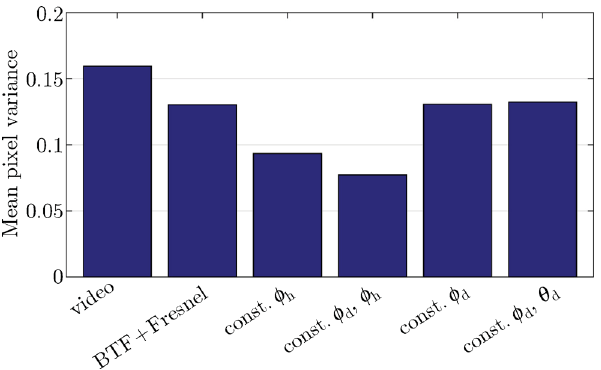
Fig. 13 Comparison of real material dynamics to dynamics of the tested representation renderings using mean per-pixel variance across entire object in Fig. 12, computed across 720 frames varying point-light position over the